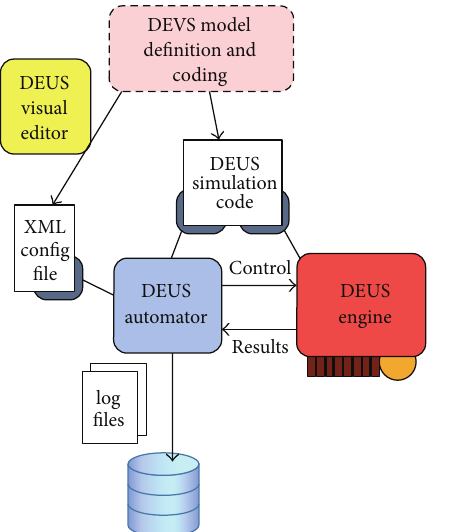
Figure 3: Discrete event simulation with DEUS, driven by DEVS models.